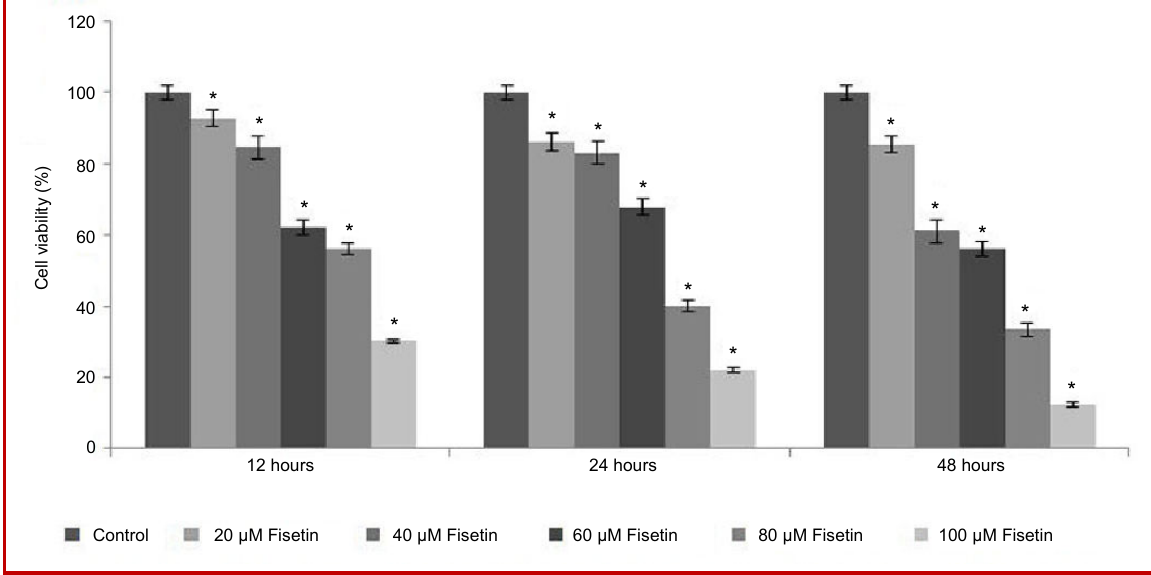
Figure 1: Effect of fisetin on the cell viability of U-2 OS cells Values are represented as mean ± SD; n=6; *represents p<0.05 compared with control as determined by one way-ANOVA